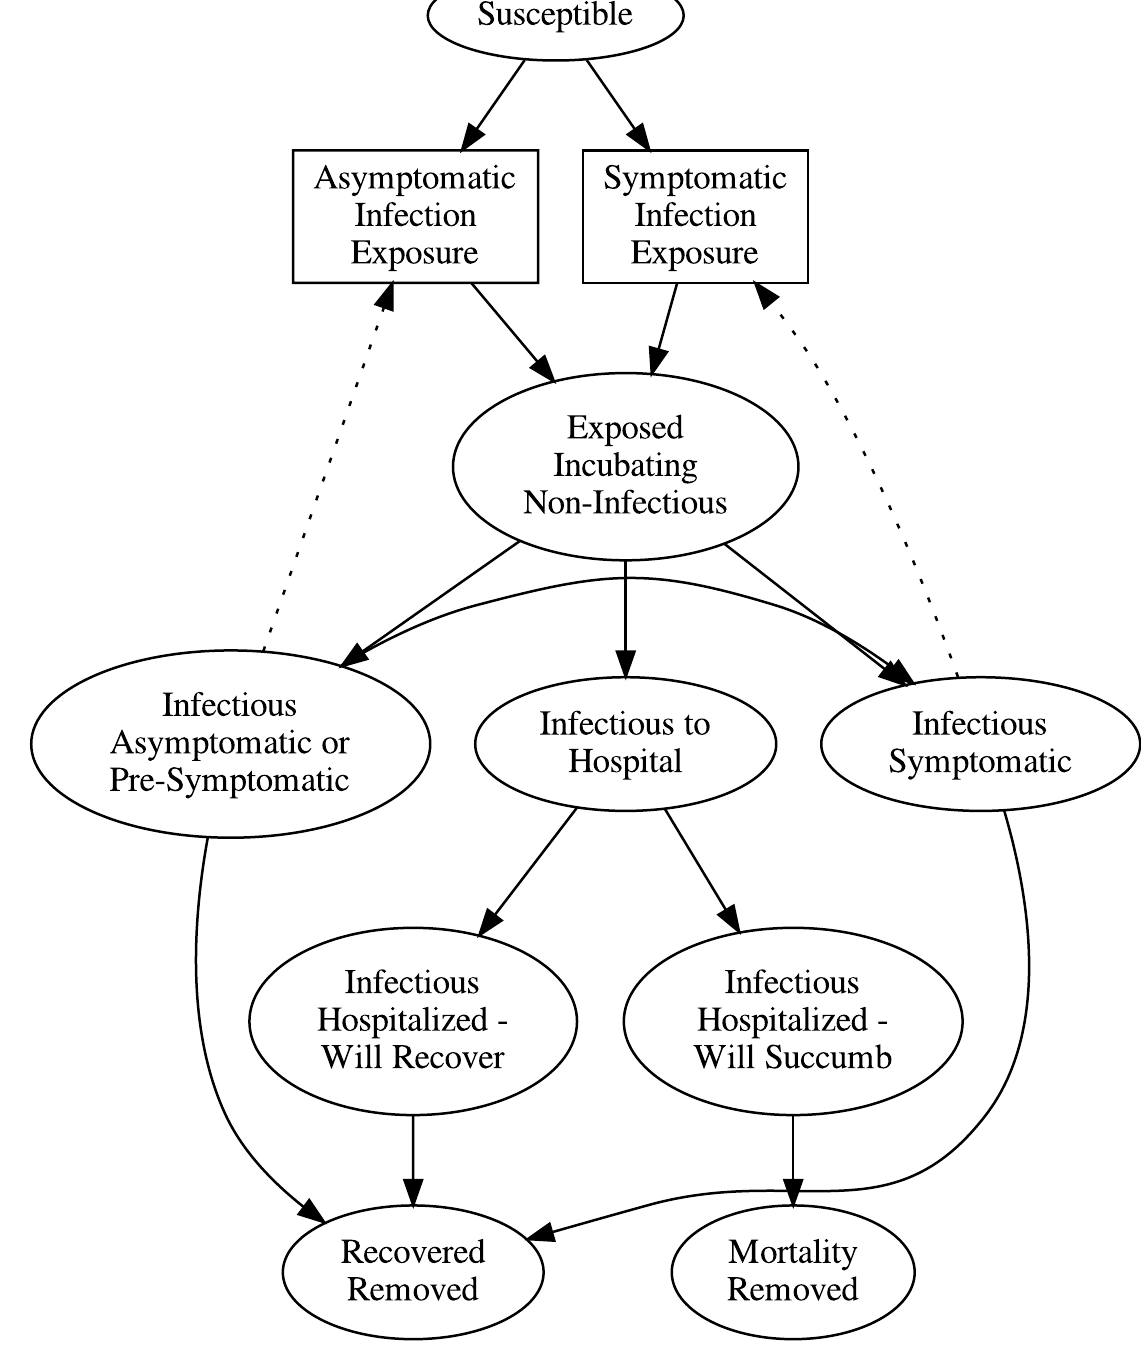
Figure 1. Classifications in the compartment model. Ovals represent conditions of members of the population. These include: susceptible, latent exposed, infectious who have been identified or are symptomatic and isolated, infectious who have not been identified, and who are pre-symptomatic, asymptomatic, infectious who will be hospitalized as severe or critical, those who are hospitalized but will recover, those who are hospitalized who will succumb, those who recovered, and those who passed away. Solid arrows represent conversions from one state to another, with a fixed rate. Dotted arrows represent infectious interactions that promote conversion from susceptible to latent exposed. Each dotted arrow provides a component for that particular infectious group. β is reduced for isolated individuals compared to pre-symptomatic and asymptomatic spreaders. Rectangular boxes reflect the flow through mediated by dotted arrow input: β